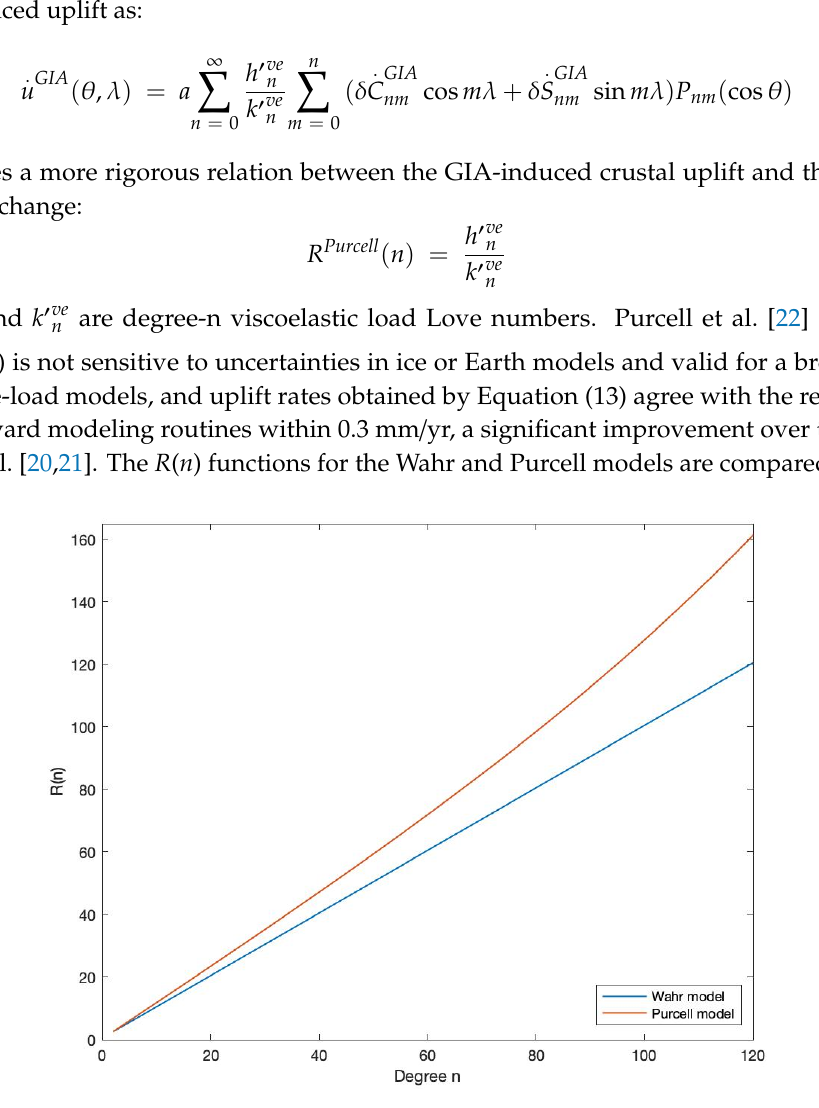
Figure 8. R ( n ) functions for the Wahr and Purcell models, respectively.